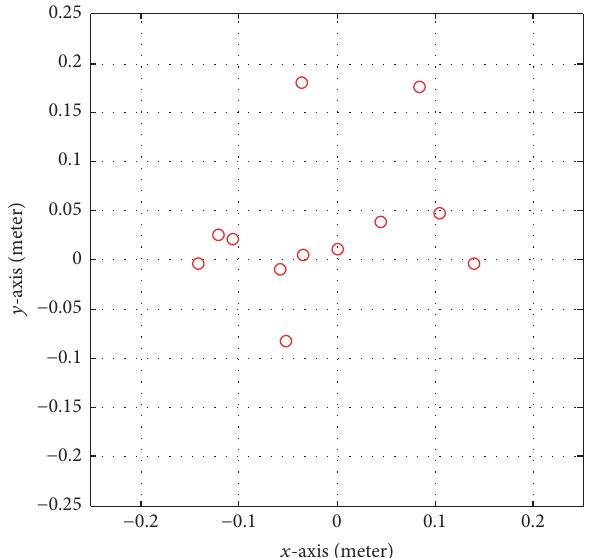
Figure 6: The location of the targets in 𝑥𝑦 -plane.